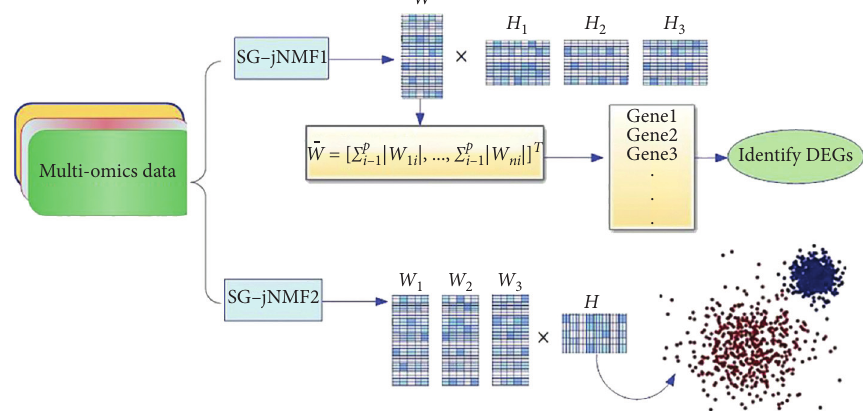
Figure 1: Framework of